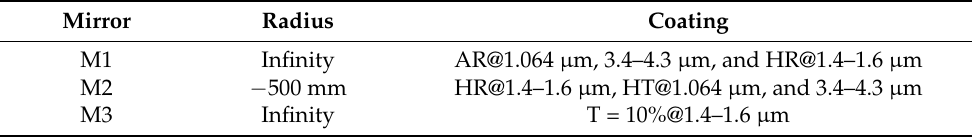
Table 1. Mirror parameters used in the OPO and the negative sign represents a concave